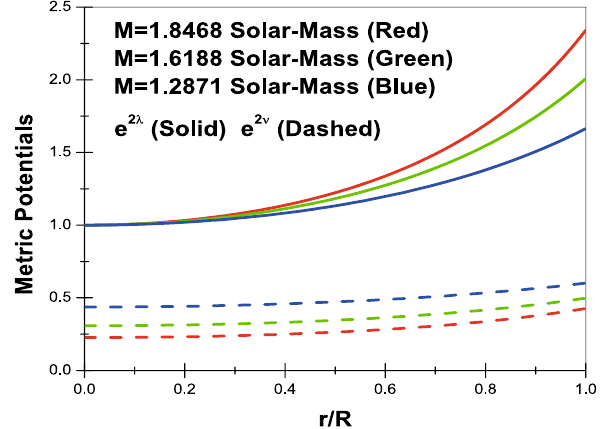
Fig. 1 Variation of metric potentials with the dimensionless radial coordinate r / R with R = 9 . 5 [ km ] and for different values of the parameters A , B , C and F mentioned in Table 1